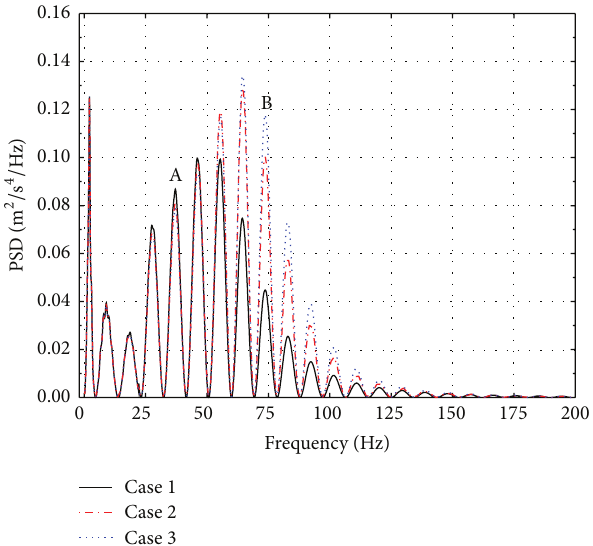
Figure 8: Power spectral density (PSD) of the vertical random vibration acceleration of a vehicle bogie due to the linear secant stiffness, the nonlinear frequency-dependent stiffness, and the non- linear amplitude- and frequency-dependent stiffness of rail pads.